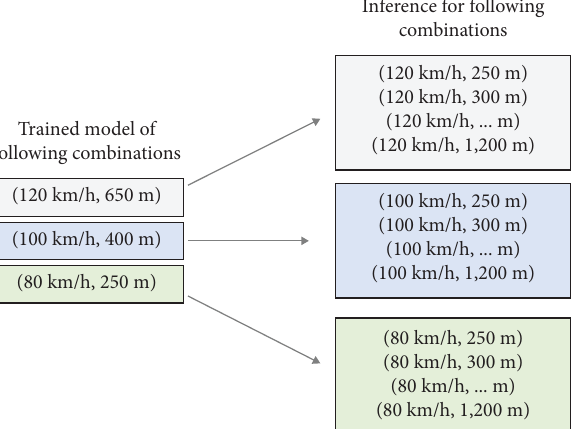
Figure 6: Training and inference logic. Train the reference model as a base and apply the reference model to diferent scenarios.